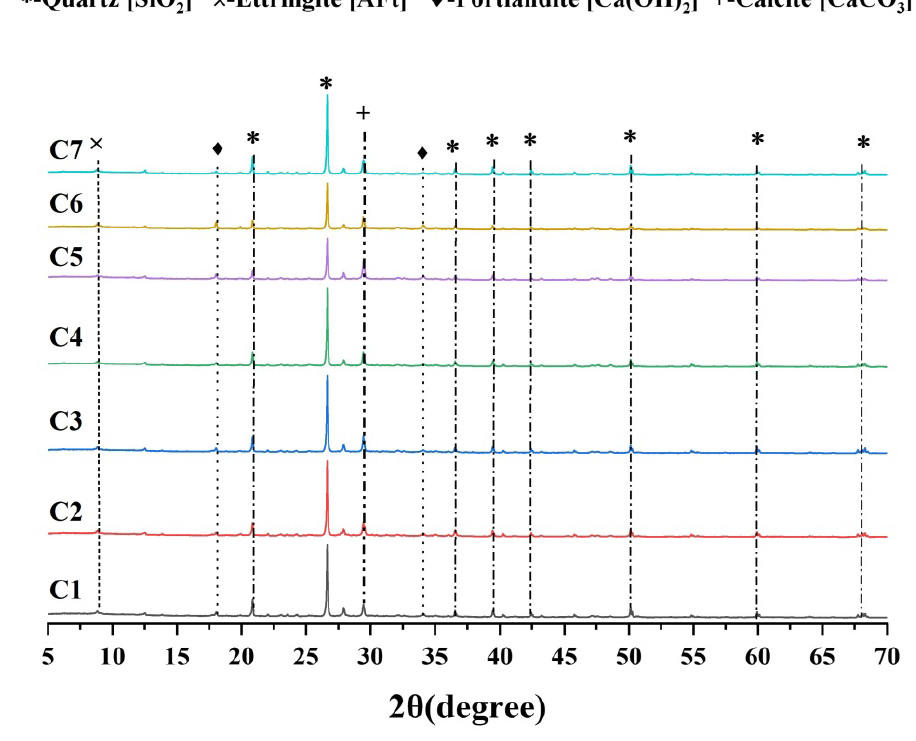
Figure 5. XRD results of different specimens.